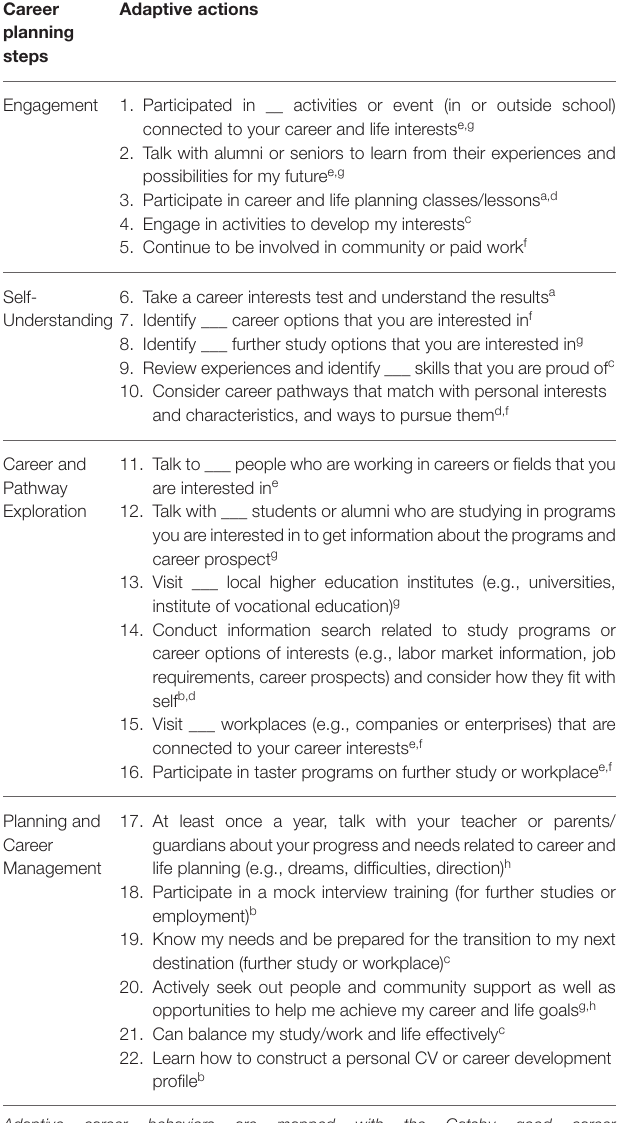
TABLE 2 | Adaptive career actions from the career adventure report of the infinity system. Career